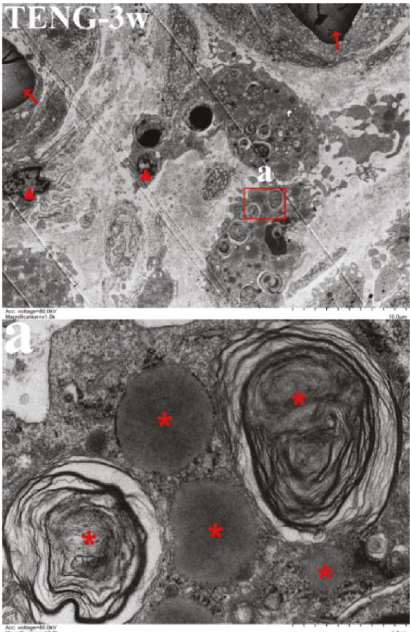
Figure 7: Electron microscope ultrastructure of the regenerated nerve tissue proximal to the catheter 3w after operation in the TENG